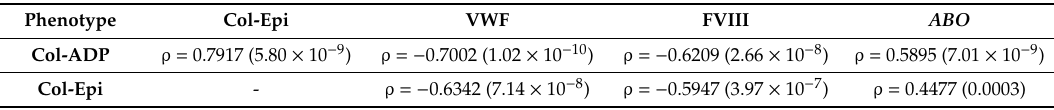
Table 1. Genetic correlations among PFA phenotypes, von Willebrand factor, coagulation factor VIII and ABO